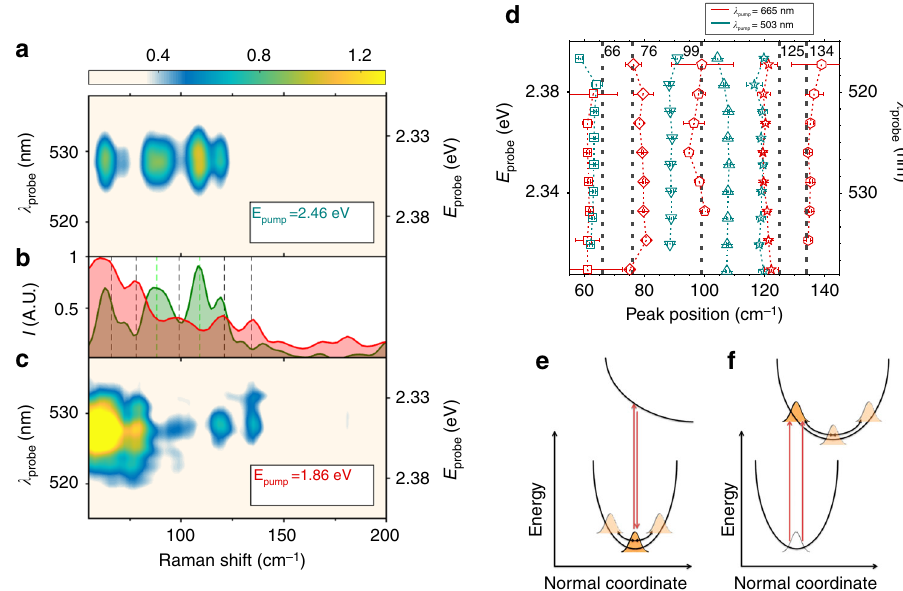
Fig. 2 Impulsive vibrational spectroscopy on MAPbBr 3 under different resonance regimes. Probe-wavelength resolved IVS maps, upon resonant ( E Pump = 2.46 eV) and non-resonant ( E Pump = 1.86eV) excitations ( a , c , respectively). The maps have been obtained by Fourier transforming the oscillating component of the TA data (see Fig. 1), to retrieve the vibrational spectra. b Average of the IVS maps over different probe wavelengths. Green and red shaded Raman spectra refer to resonant and non-resonant conditions, respectively. d Fitted peaks positions of the measured Raman modes (with the corresponding 95% con fi dence boundaries) as a function of the probed wavelength. Red and green symbols refer to Raman modes obtained by pumping at 1.86 and 2.46eV, respectively. Vertical dashed lines indicate the position of MAPbBr 3 ground state vibrational modes reported in literature 25 . e , f Representations of the ISRS and DECP processes, respectively. The red arrows indicate the double interactions with the pump pulse, which generates a vibrational coherence in the ground and excited state 27 . In ISRS, immediately after photoexcitation, the vibrational wavepacket is peaked at the equilibrium position and then starts oscillating along the normal mode coordinate. In DECP, the ground state wavepacket is projected onto the excited state, where it begins oscillating from a starting position far from the equilibrium. We stress that for other class of materials, as III – V semiconductors, additional generation mechanisms are possible